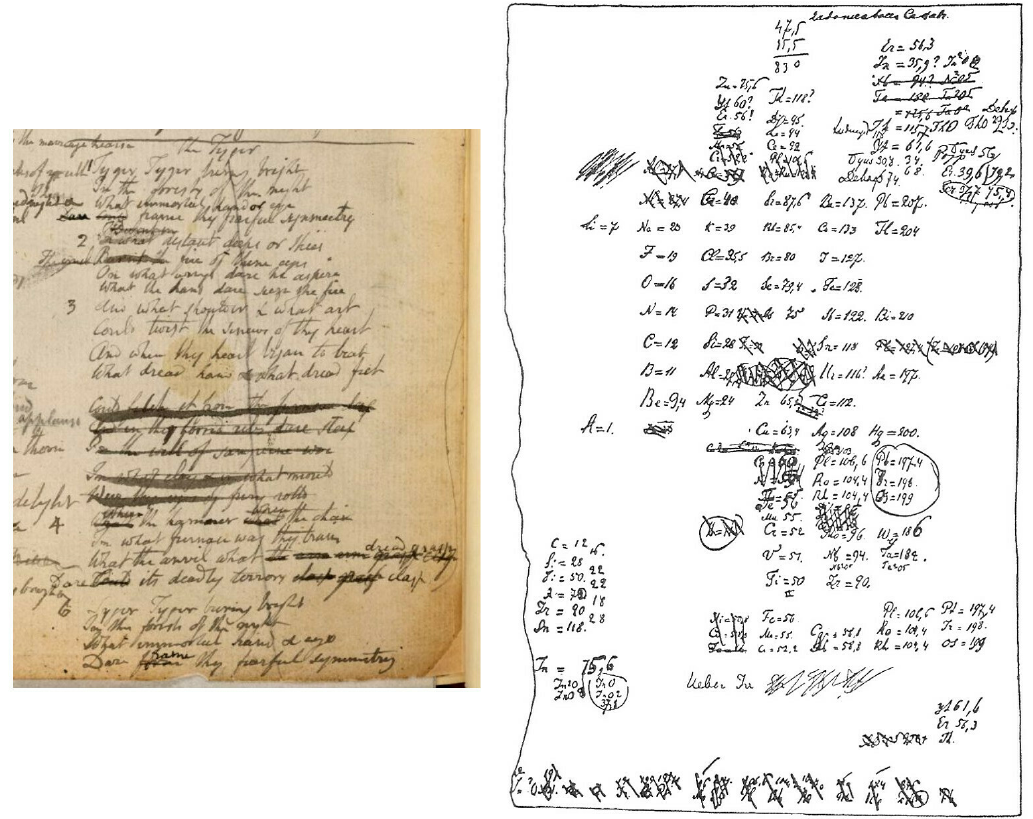
Figure 1 . Examples of messy creativity. Left : The first draft of William Blake’s poem, The Tyger (source: Right : An early draft of Mendeleev’s periodic table of the